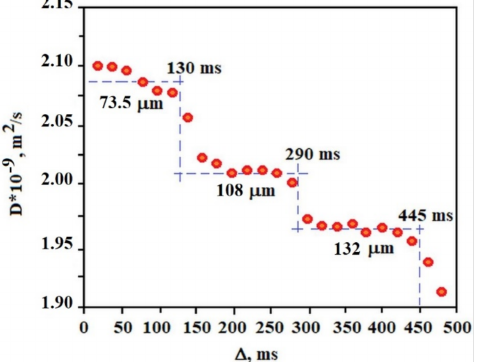
Figure 7. The diffusion time dependence of diffusion coefficient D eff ( ∆ ) of solvent molecules in C 12